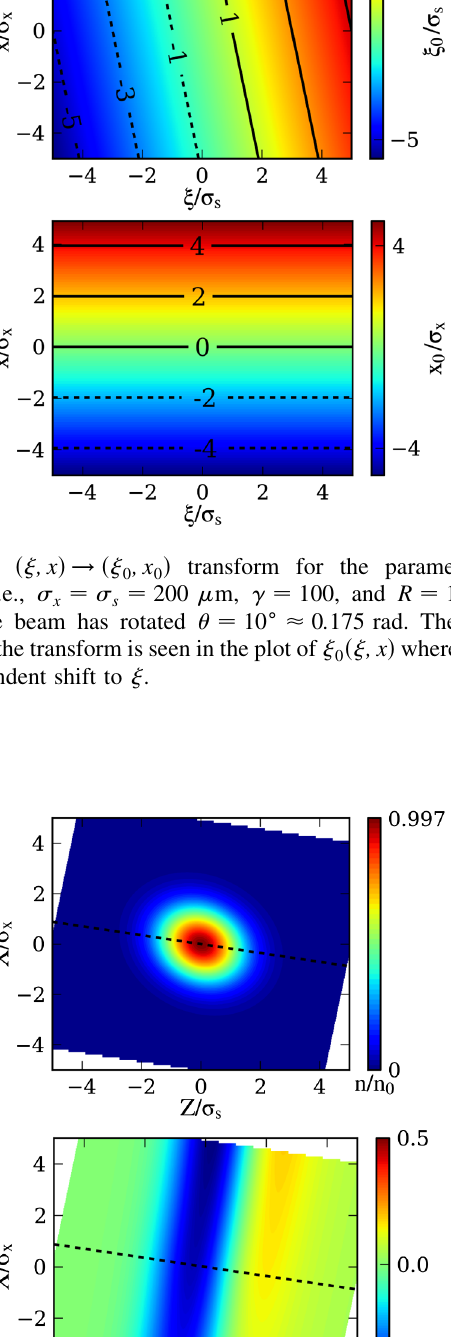
and the total longitudinal 0 is 0